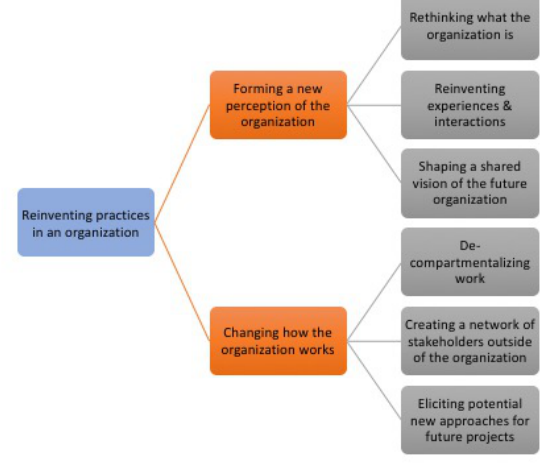
Fig. 3. Key steps to reinvent practices in an